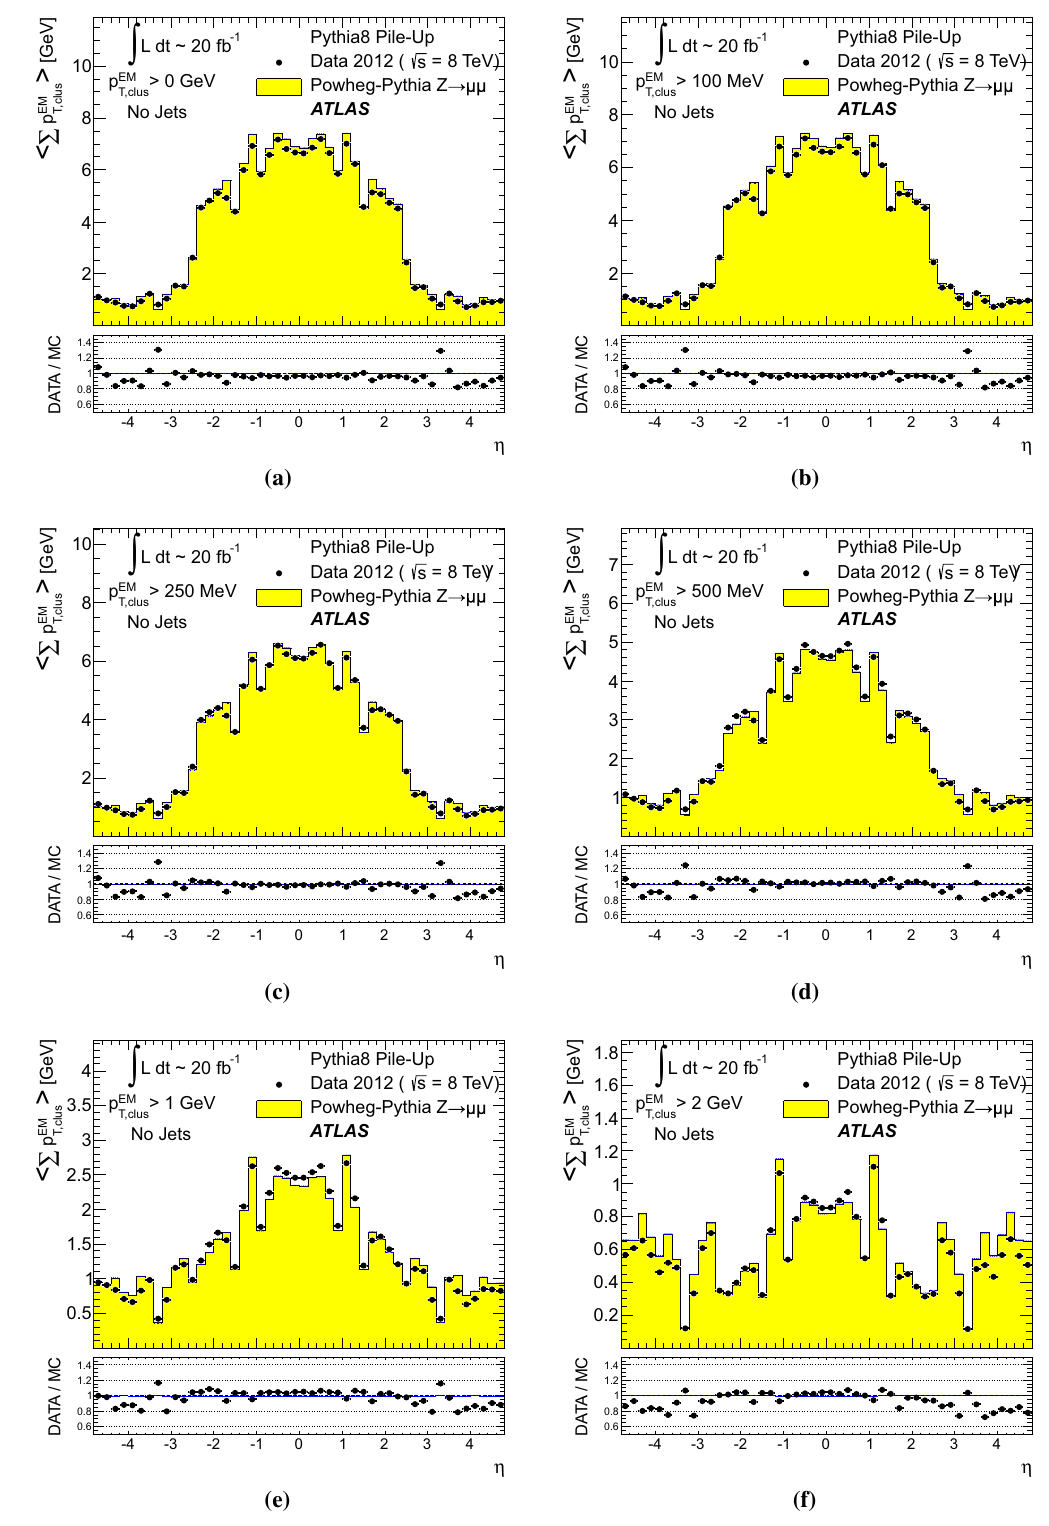
(cid:8) of clusters at the EM scale, calcu- Fig. 23 The average (cid:7) (cid:20) p EM 2012 Z → μμ sample without jets with p T > 20GeV in data and MC T , clus simulation. The ratios of (cid:7) (cid:20) p EM > 0, lated as function of η using Eq. (41), for clusters with a p EM T , clus are shown below each > 100MeV, c p EM > 250MeV, d p EM > 500MeV, b p EM T , clus T , clus T , clus > 1GeV, and f p EM > 2GeV. Results are obtained from a e p EM T , clus T , clus